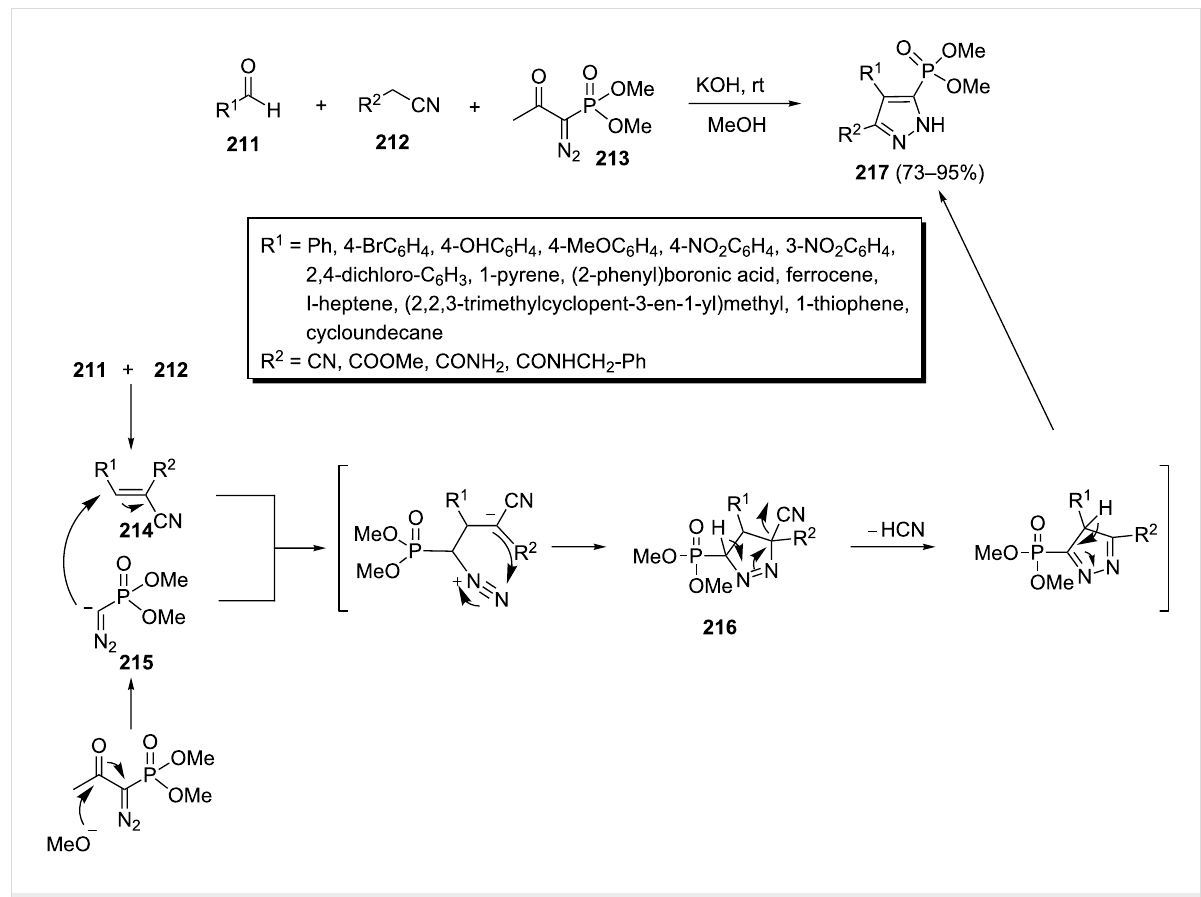
Scheme 44: Three-component synthesis of